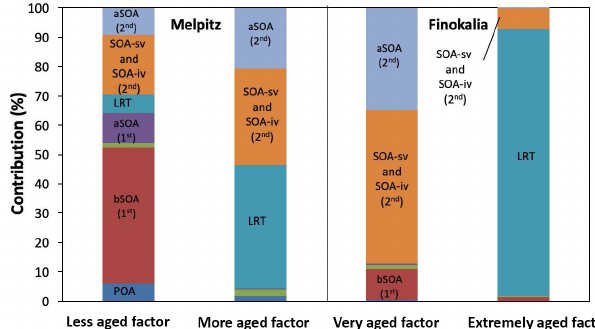
Figure 10. Contribution of first generation and second plus later generations of SOA components to each factor in Melpitz and Fi- nokalia during May